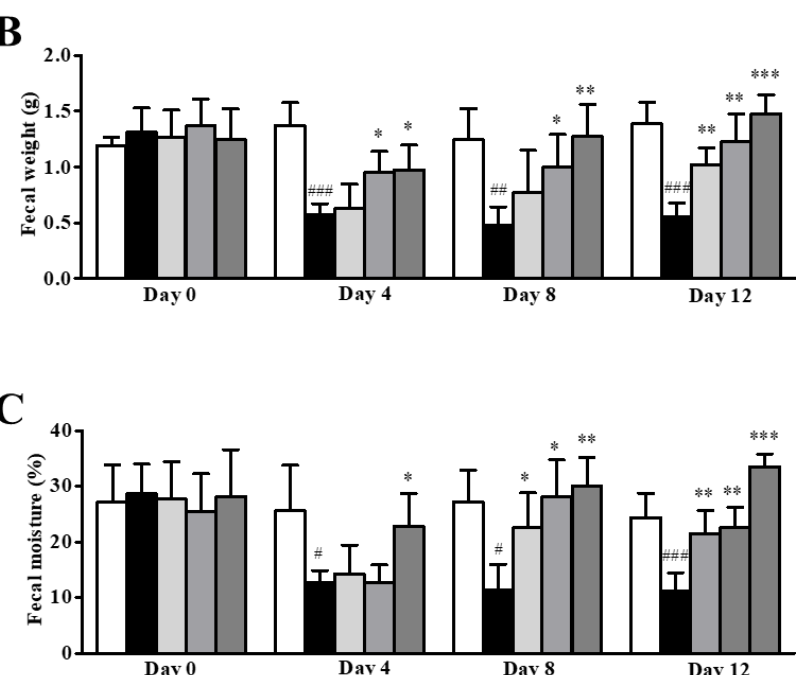
Figure 6. The preventive effects of D. morbiferus H. L é v. leaf extract (DPL) on loperamide-induced constipation. At 0, 4, 8, and 12 days, the total number ( A ), weight ( B ), and water content ( C ) of stools were measured. The fecal water content was calculated using the fresh and dry weights of stools. # Significant difference at p < 0.05, ## at p < 0.01, and ### at p < 0.001 compared with the control group (CTL). * Significant difference at p < 0.05, ** at p < 0.01 and *** at p < 0.001 compared with the